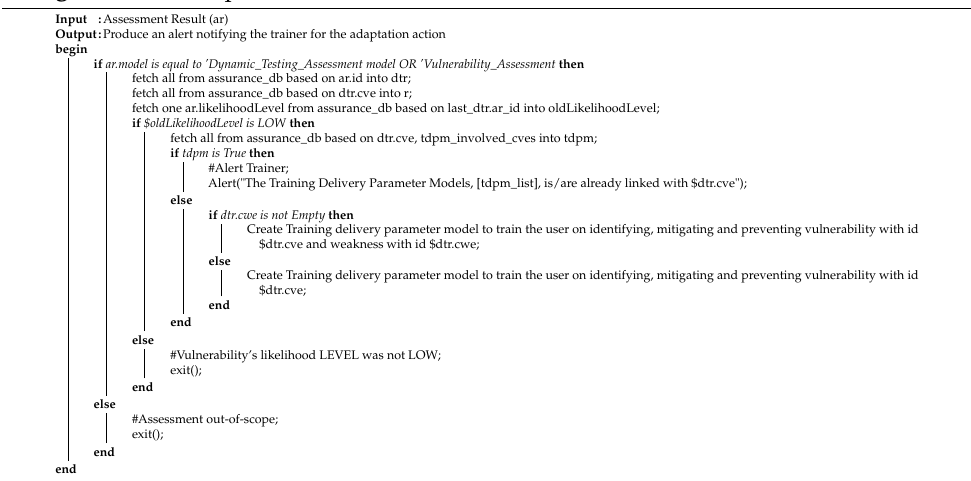
Algorithm 4: Adaptation based on a likelihood